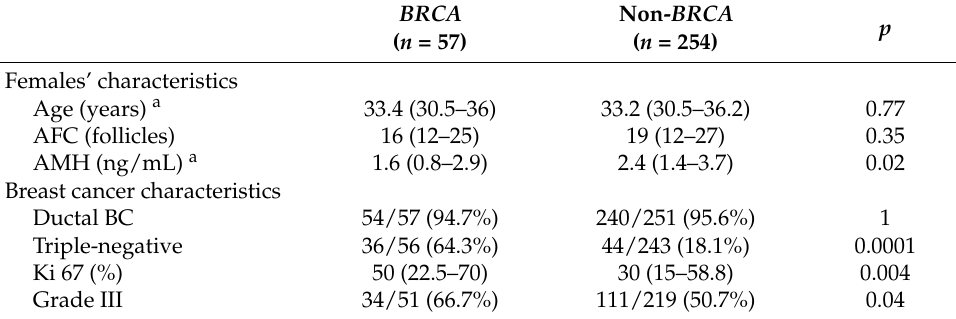
Table 1. Females’